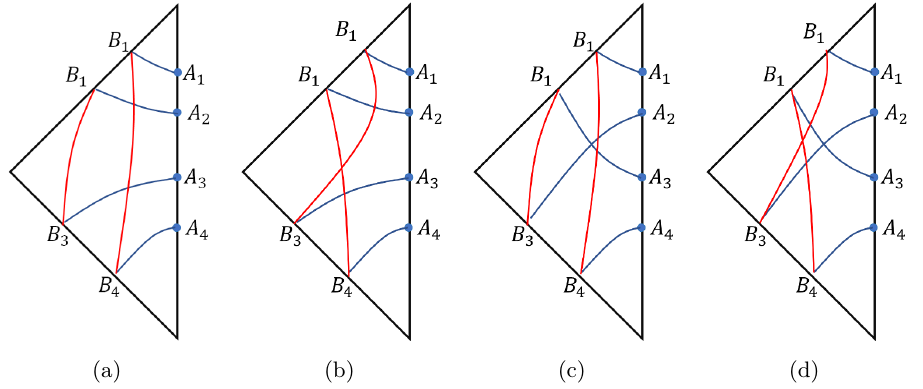
Figure 8 . Four of 12 different possible configurations of geodesics for two disjointed timelike intervals. that configuration (c) cannot be a CWES. Using the result of eq. (3.17) we can find